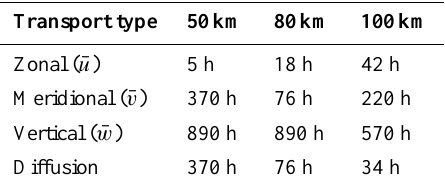
Table 6. Characteristic transport lifetimes (Brasseur and Solomon, 1986)